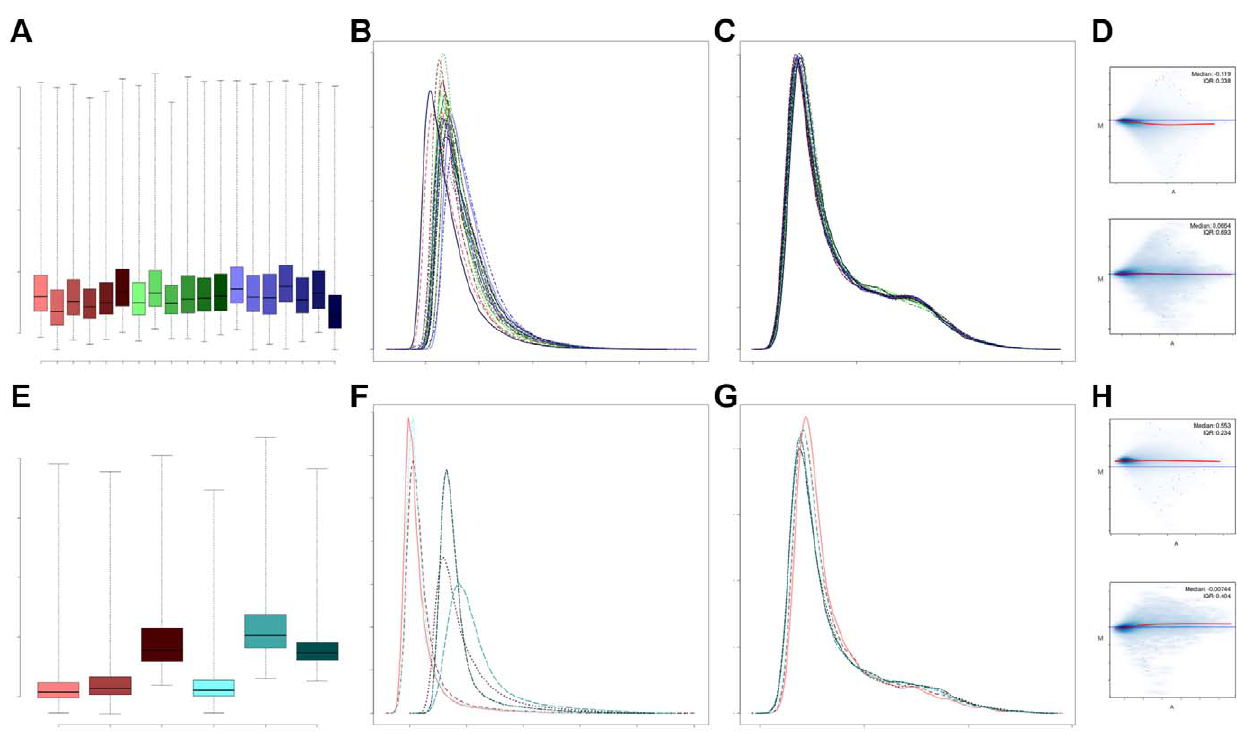
Figure 2. Overview of the QC results of two selected datasets. Several QC results of the dataset by Varambally et al. comparing arrays of benign prostate tissue (maroon), primary prostate cancer (blue) and metastatic prostate cancer samples (green) are shown in panel a-d. Several QC results of the dataset by Gregg et al. comparing arrays of prostatic epithelial (maroon) with interstitial stromal cell samples (teal) are depicted in panel e-h. a) Boxplot of raw intensities; b) density histogram of log intensities before normalization; c) density histogram of log intensities after normalization; d) MA-plot before (upper panel) and after normalization (lower panel) of one example array of the dataset by Varambally et al. ; e) boxplot of raw intensities; f) density histogram of log intensities before normalization; g) density histogram of log intensities after normalization; h) MA-plot before (upper panel) and after normalization (lower panel) of one example array of the dataset by Gregg et al.